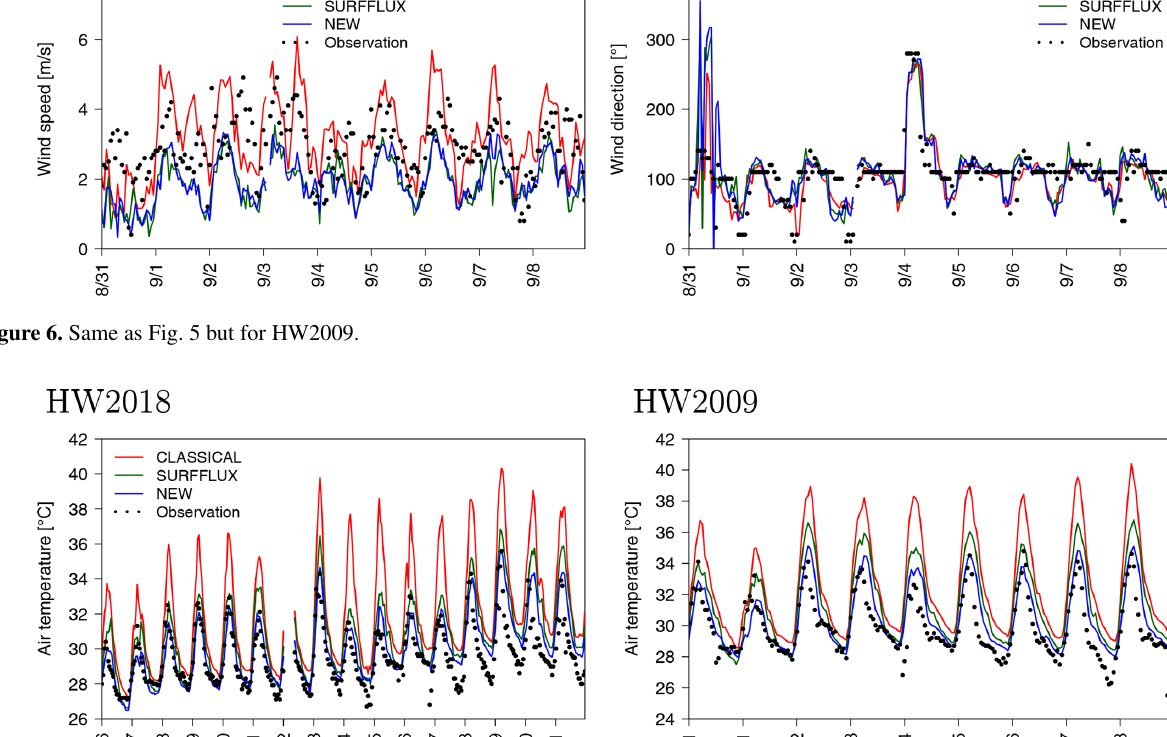
ably improved for NEW and HW2009. At the rural stations, evaluation measures for wind speed are slightly improved for HW2018 and not consistently changed for